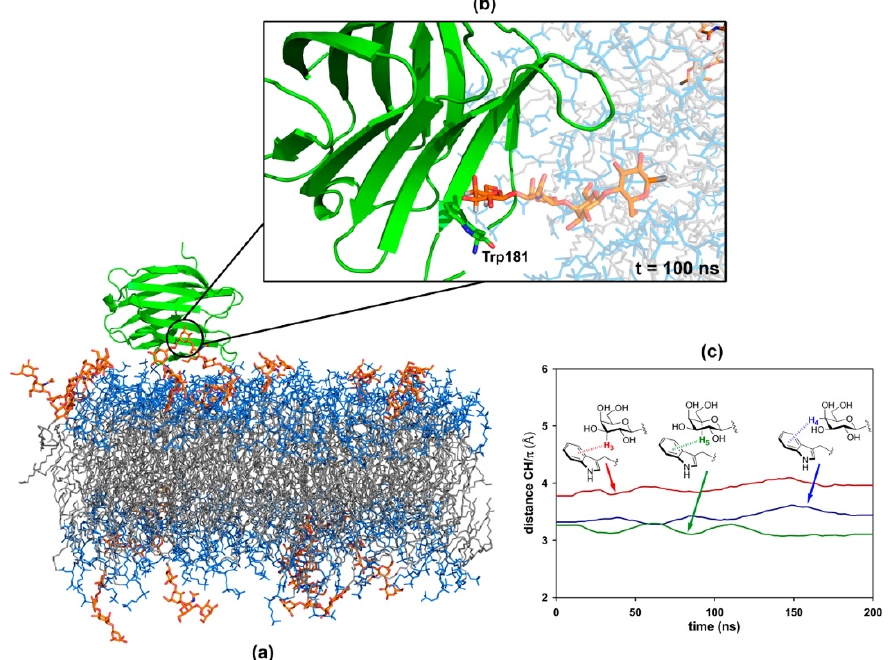
Figure 9. The CH- π interaction between the terminal β -Gal residue in aGM1 and Trp181 of Gal3 CRD is kept along the MD simulation. ( a ) Simulation of the interaction of the POPC:aGM1 bilayer with Gal3; ( b ) Snapshot (t = 100 ns) showing the key CH/ π interaction with the key β− Gal residue of aGM1; ( c ) Distances (Å) between Gal H-3, H-4 and H-5 and the centroid of Trp181 aminoacid. Color code: Gal3, in green; glycan residues in orange; phosphocholine (PC) in blue; palmitoyl (PA), oleoyl (OL) and ceramide (CER) moieties in grey.